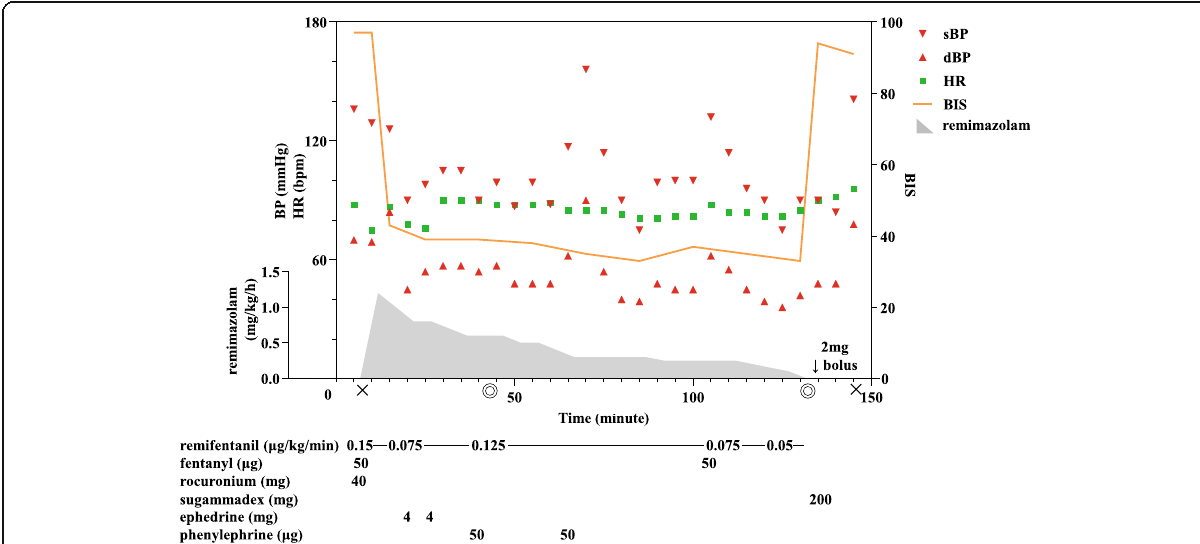
Fig. 1 Anesthetic chart for case 1. Double circles and crosses represent the start/end of surgery and start/end of anesthesia, respectively. sBP, systolic blood pressure; dBP, diastolic blood pressure; HR, heart rate; BIS, bispectral